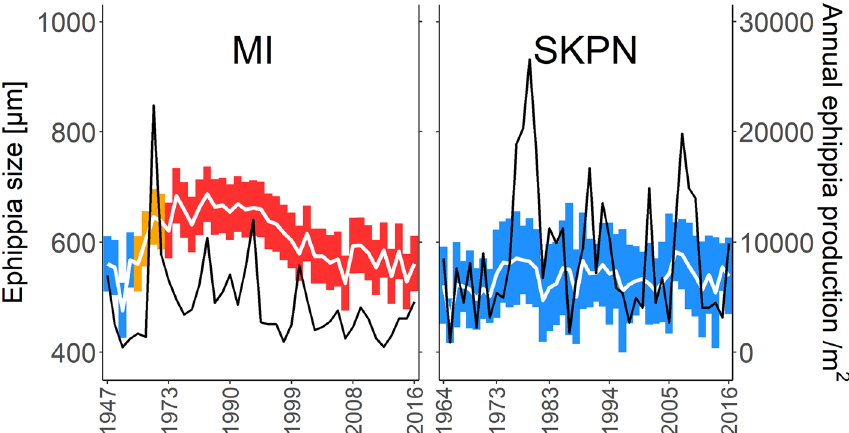
Figure 7. Size (white line and bars indicate mean ± SD, respectively) and annual flux of ephippia per m 2 of sediments (black line) of Daphnia individuals extracted from sediments produced in the analysed time points (presented on x-axis) in heated Lake Mikorzyńskie (MI) and control Lake Skulska Wieś (SKPN). Colours of bars indicate the thermal status of the lake at a given timepoint (blue—non-heated, yellow—heated (after the launch of the first power plant), red—heated (after the launch of the second power plant). Age model is based on the present study for MI and Woszczyk et al. 31 for